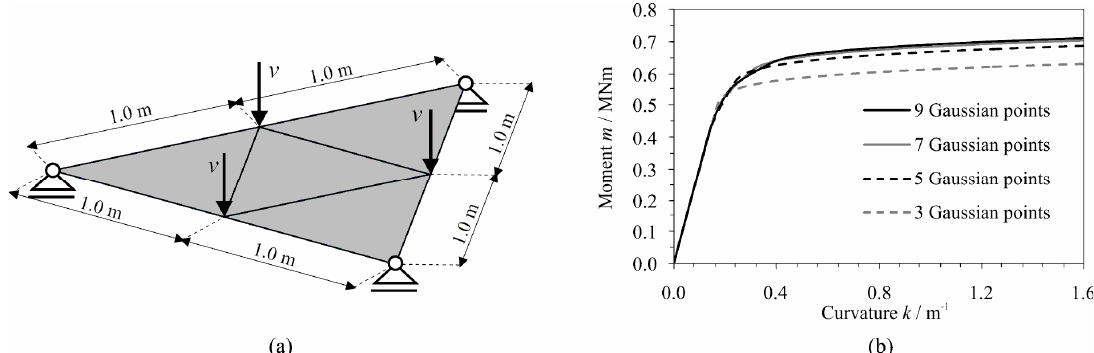
Figure 8. Triangle plate: ( a ) geometry and loading condition; and ( b ) relation between bending moment at the edge of the centre finite element and the corresponding curvature.